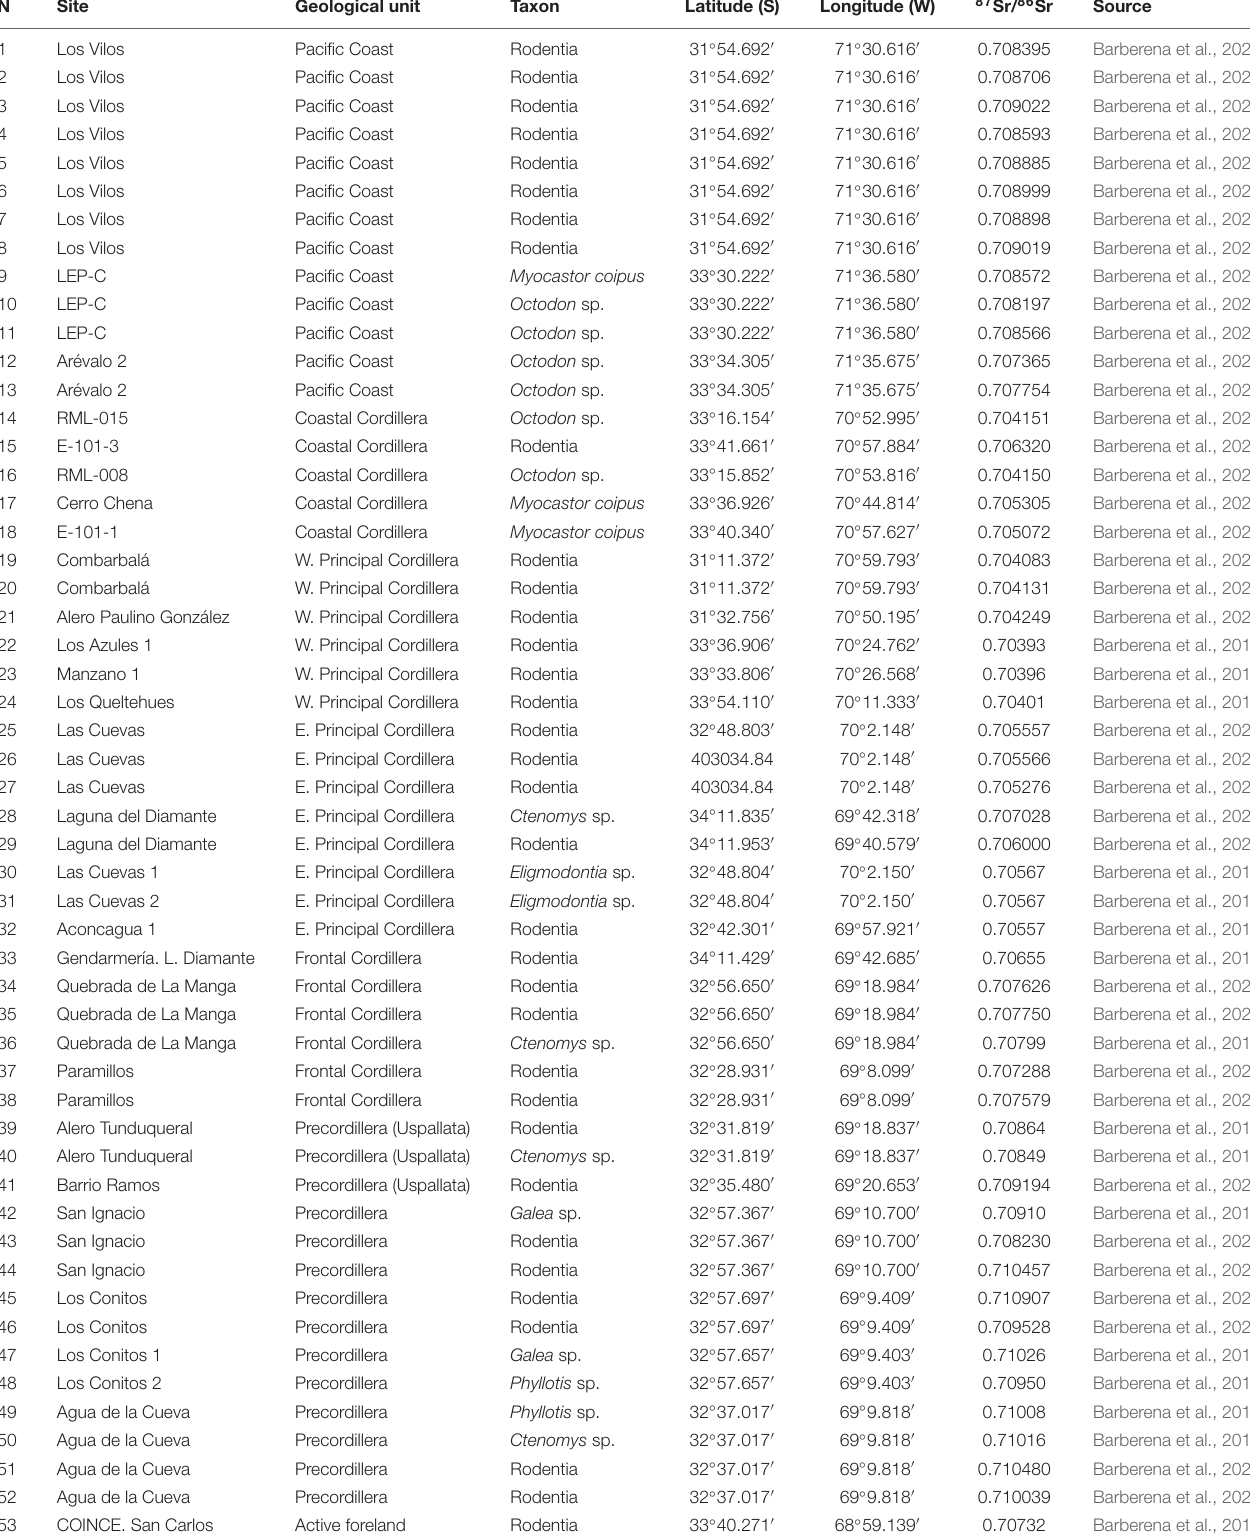
TABLE 3 | 87 Sr/ 86 Sr results for rodent samples from the southern Andes (Argentina and